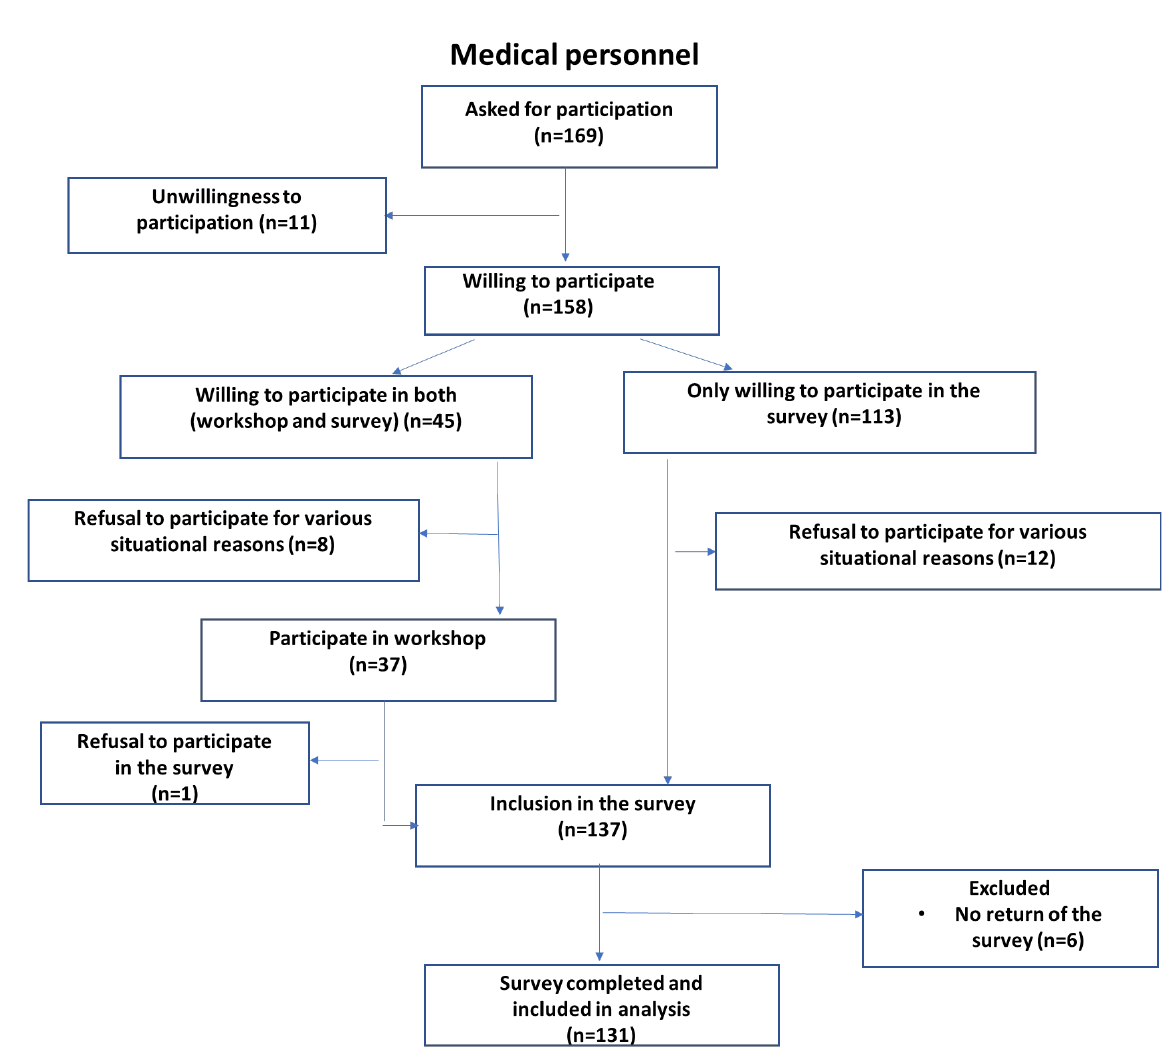
Figure 2. Medical personnel recruitment flow chart.